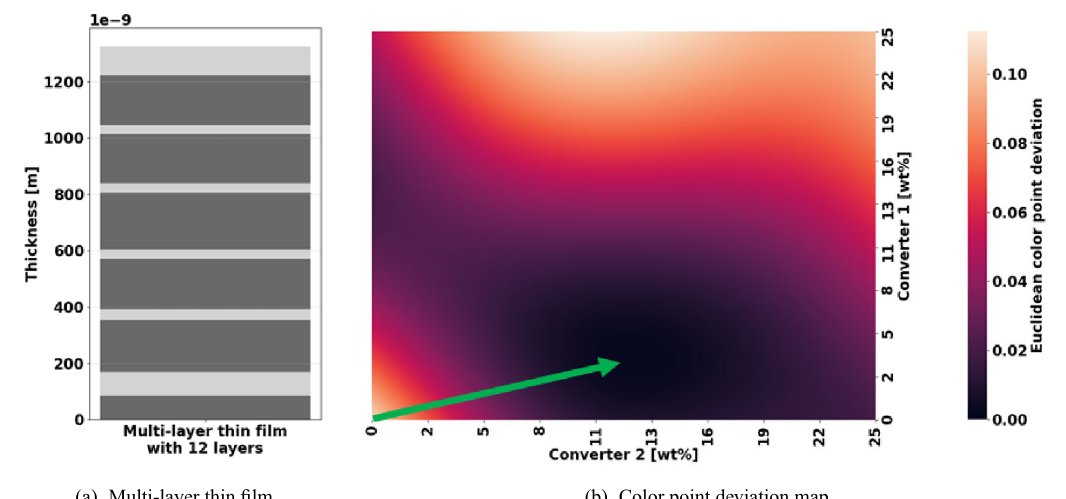
Figure 2. ( a ) Illustration of a multi-layer thin film consisting of two dielectric materials ( TiO 2 in light grey and SiO 2 in dark grey). ( b ) The heatmap of the Euclidean color point deviation over weight percentages of two conversion materials for the multi-layer thin film in ( a ). The green arrow indicates the possible path of a local optimizer initialized near the origin of the search space to the optimal converter weight